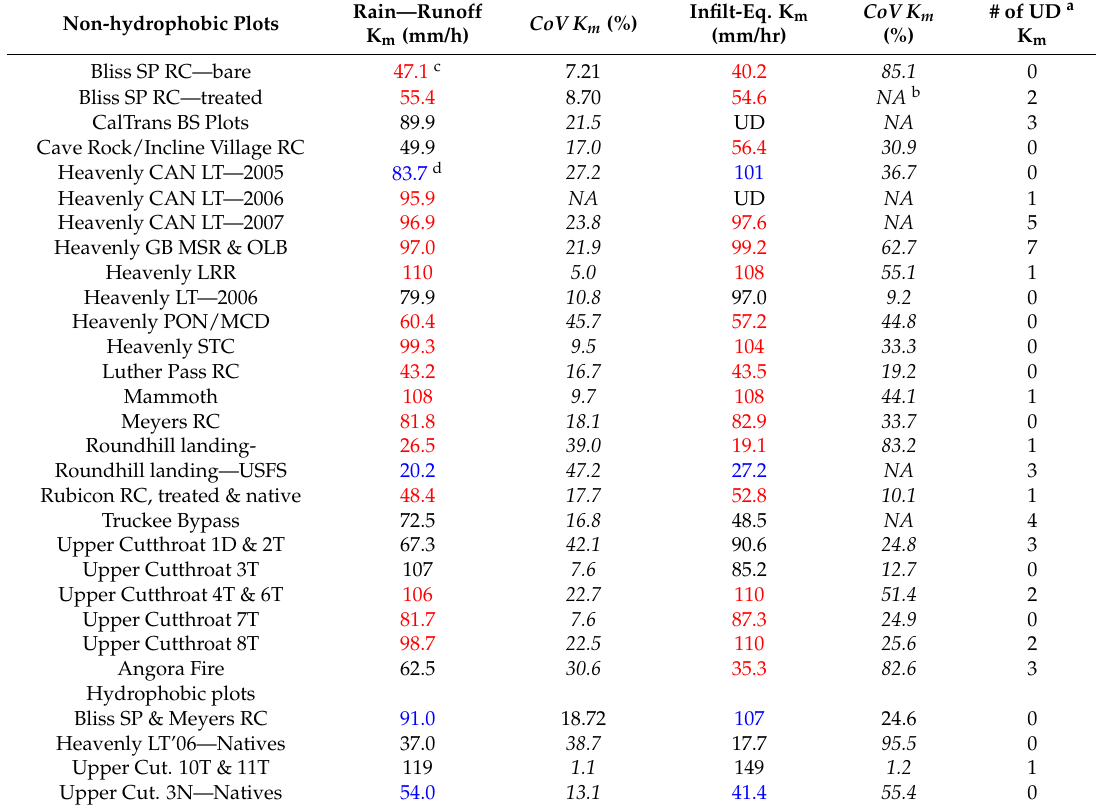
Table 9. Summary of steady Rain–Runoff and Infiltration Eq. K m values for granitic RS plots having runoff. Non-hydrophobic